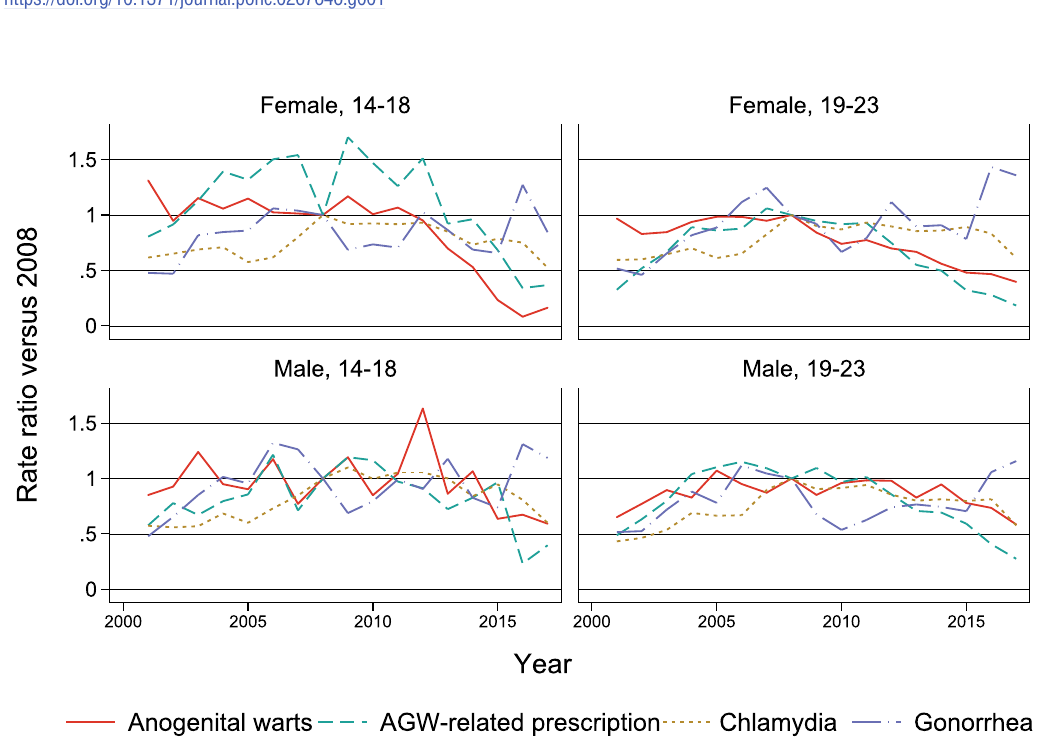
Fig 2. Age-standardized incidence rate ratios of conditions of interest (indexed to the 2008 introduction of the school-based qHPV vaccination program) by year, age group, and gender.